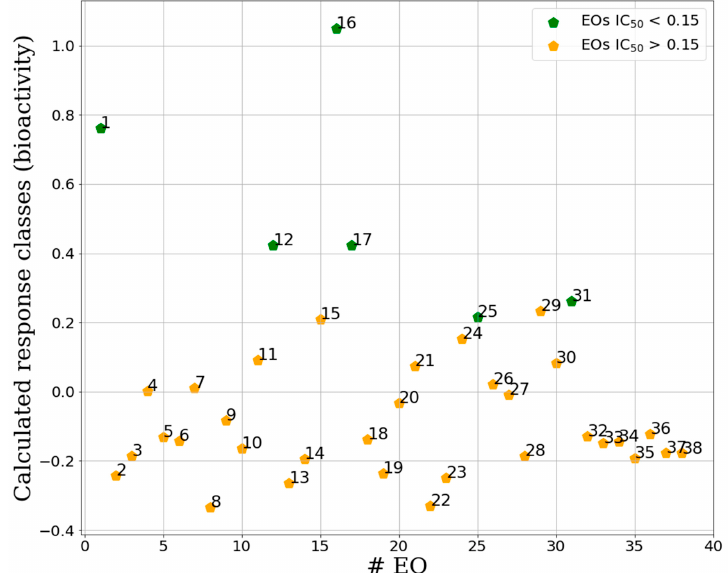
Figure 5. Separation between active and inactive samples for the binary IC 50 -PLS-DA classification model. Green samples are the active class, orange the inactive. On the y-axis are reported the calculated response for the activity class calculated by the PLS-DA technique (X score × Y weights) for each EO (x-axis) [24] (Table 1). Samples at the top of the plot were assigned to active class while those at the bottom were classified as inactive. Calculated response classis values between 1 and 0 indicate active samples, while values lower than 0 indicate samples belonging to the inactive class.